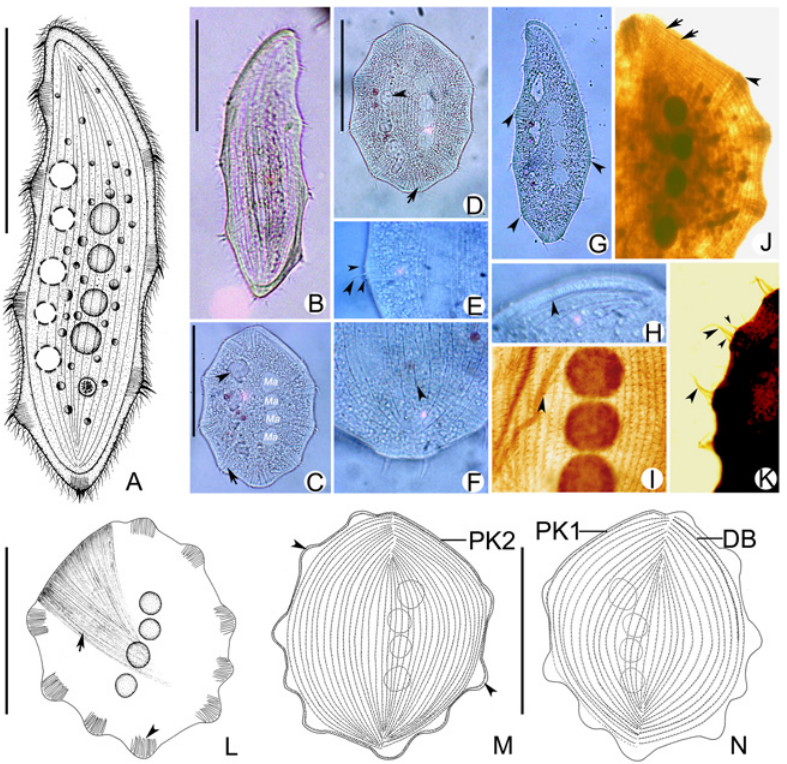
Fig 4. Kentrophyllum verrucosum ; living individuals (A – H, L – N) and cells stained with protargol (I-K). A. Right lateral view of representative specimen. B. Left lateral view of representative specimen. C, D. Right lateral views of contracted specimens; arrowheads, contractile vacuoles; arrows, extrusomes. E, K. Margin of cell under higher magnification; arrowheads, spines. F. Posterior part of left side, showing grooves (arrowheads). G. Right lateral view showing warts (arrowheads). H. Anterior part of left side showing peribuccal papillae (arrowheads). I. Middle part of right side showing somatic kineties (arrowheads). J. Right lateral view. Arrows, perioral kinety 2; arrowheads, warts. L. Distribution (arrowhead) and development (arrow) of nematodesmata. M, N. Ciliary patterns of right (M) and left (N) sides; arrows, perioral kinety 1.